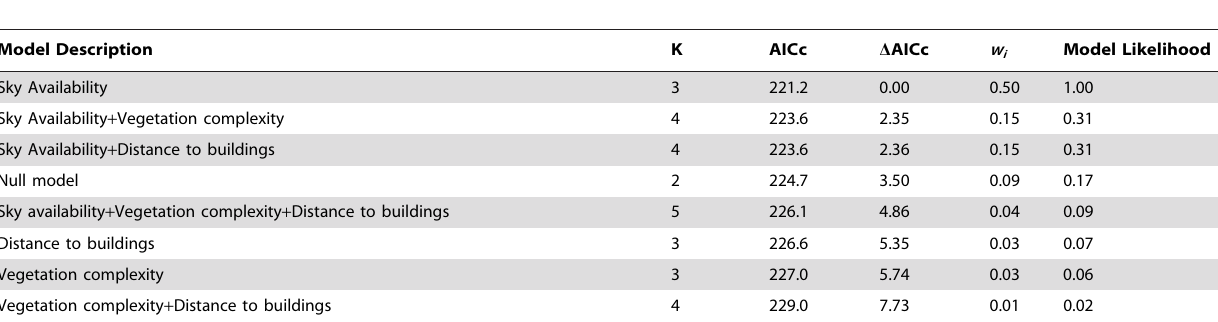
Table 3. Ranking of models explaining the fix success rate (FSR) obtained by lightweight GPS collars in different suburban habitat types and sky availability classes during stationary collar tests (n=36), Dunedin, New